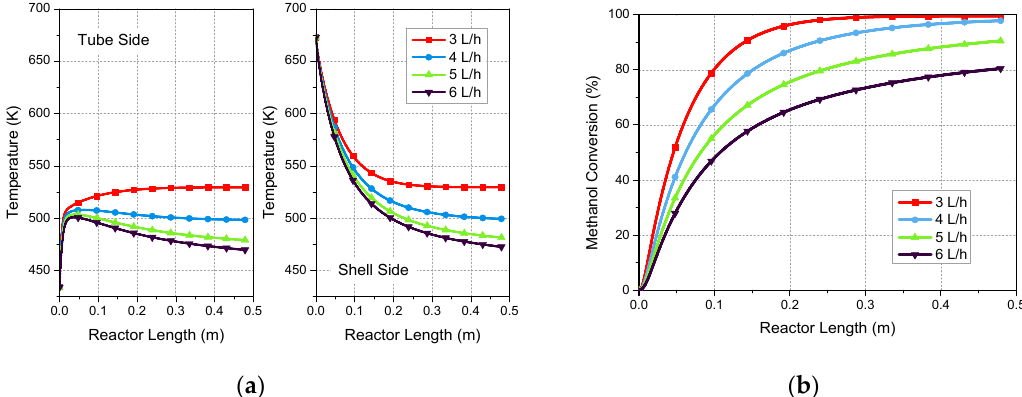
Figure 8 . The effect of the mass flow rate of methanol-and-water mixture ranging from 3 to 6 L/h on ( a ) the temperature profile of both tube side and shell side, and ( b ) the methanol conversion along the length of reactor.